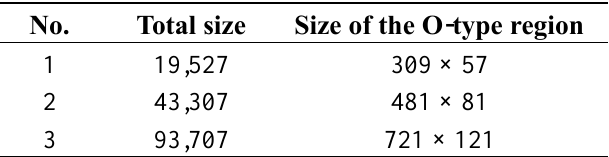
Table 1. Sizes of different grids.